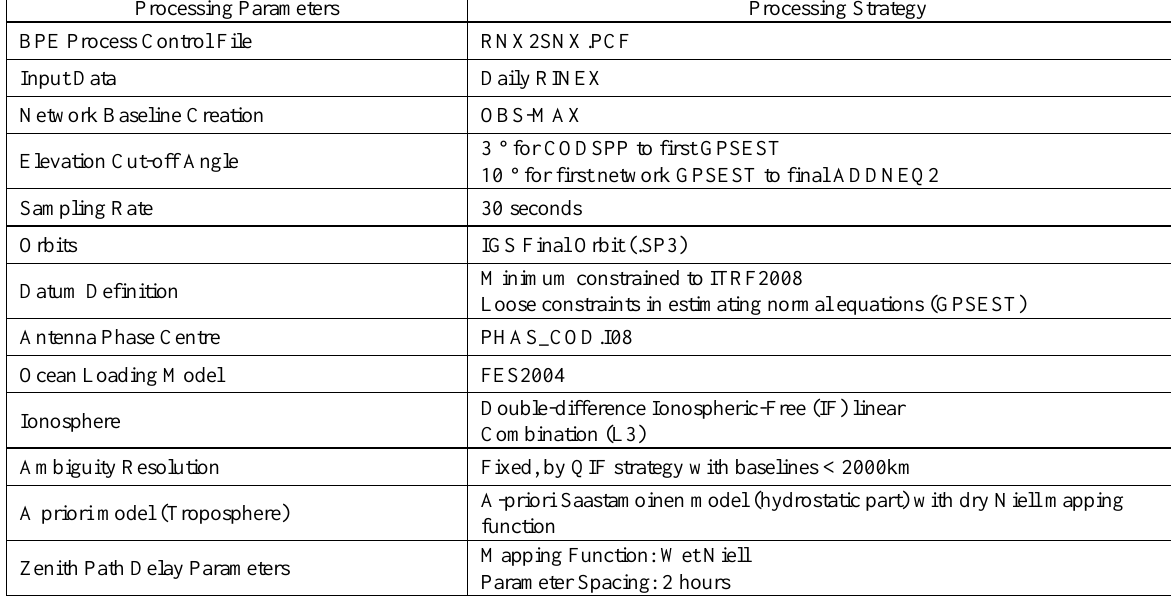
Table 4. Processing strategy and parameters used for Bernese